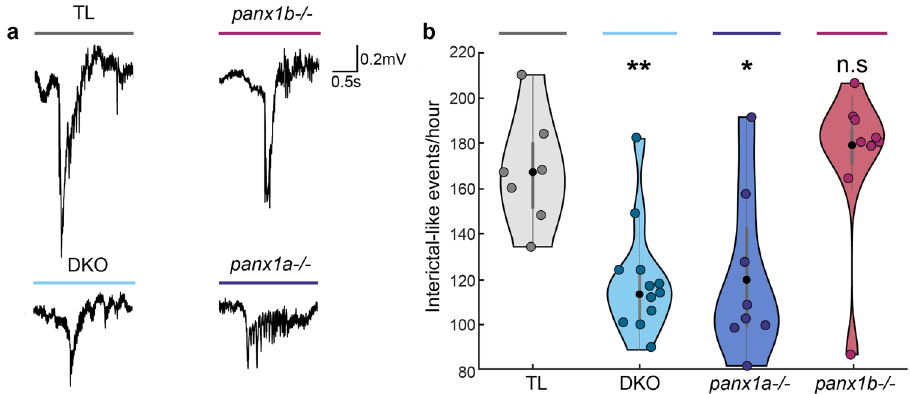
Fig. 3 Interictal-like epileptiform discharges were decreased in the optic tectum of DKO and panx1a − / − larvae. a Electrophysiological recordings of PTZ treatment showed interictal-like epileptiform discharges (IED) in all genotypes. Representative IEDs show most similarities between TL and panx1b − / − events. b Quanti fi cation of IEDs for the fi rst hour of recording for all genotypes revealed that DKO ( P = 1.3 × 10 − 3 , n = 12) and panx1a − / − ( P = 0.02, n = 8) had signi fi cantly fewer IEDs. No signi fi cant difference was found in the amount of IEDs for panx1b − / − larvae compared to TL ( P = 0.34, panx1b − / − n = 9, TL n = 7). Data presented as an average number of events per hour ± s.e.m. N = number of larvae. Scale bar: 0.2 mV by 0.5 s. * P < 0.05, ** P < 0.01, Mann – Whitney U